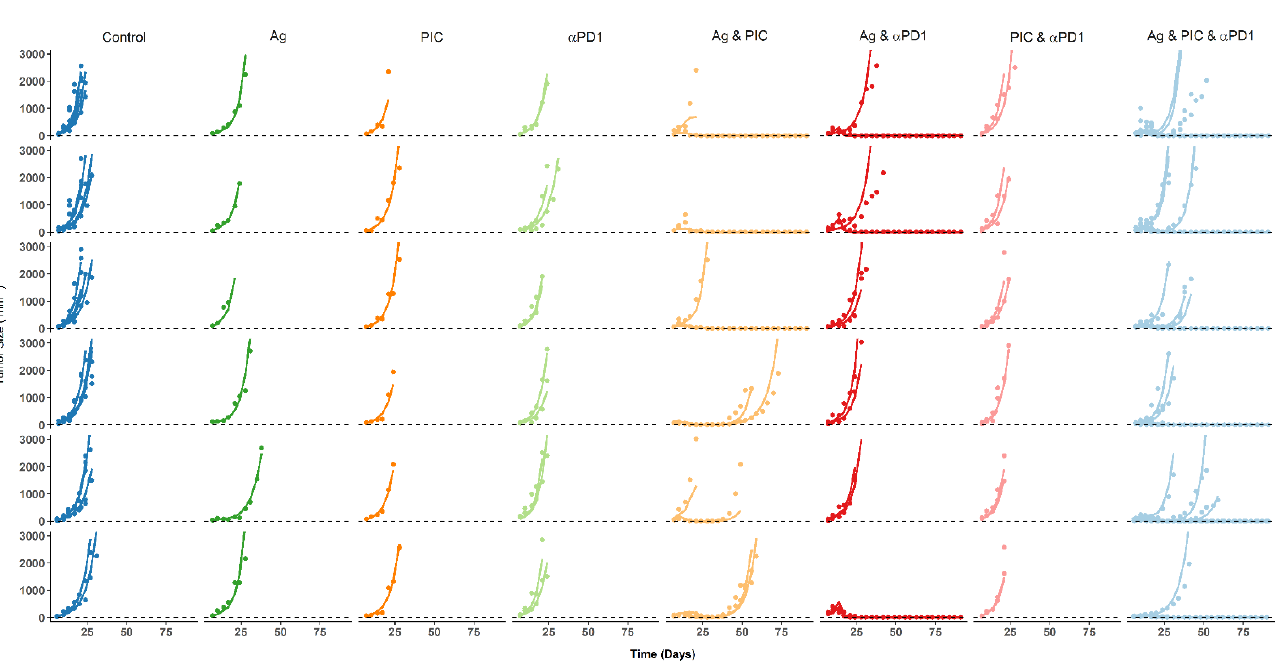
Table 3. Model parameter estimates.